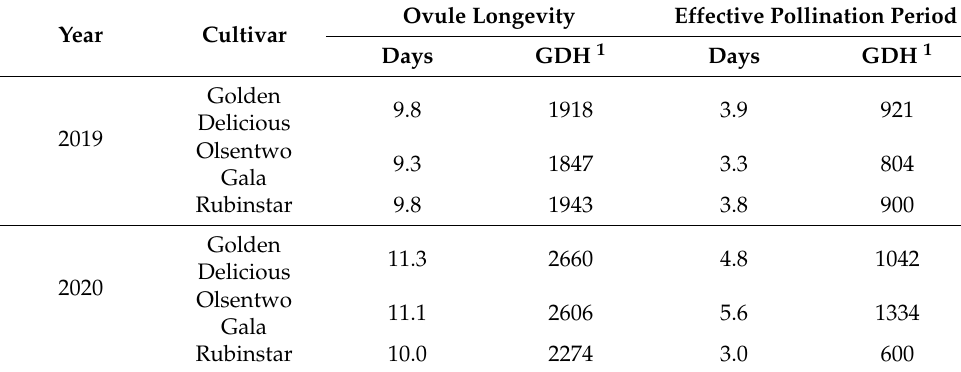
Table 3. Duration of ovule longevity and effective pollination period of ‘Golden Delicious’, ‘Olsentwo Gala’, and ‘Rubinstar’ flowers in 2019 and 2020.